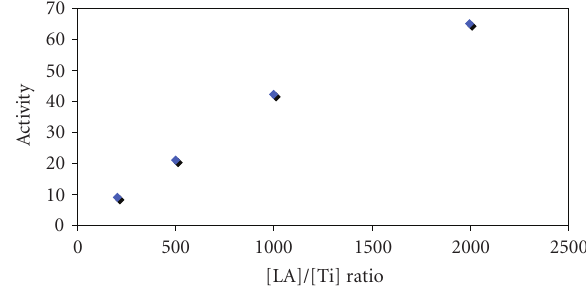
Figure 1: Variation of the activity as a function of the monomer/ catalyst ratio.